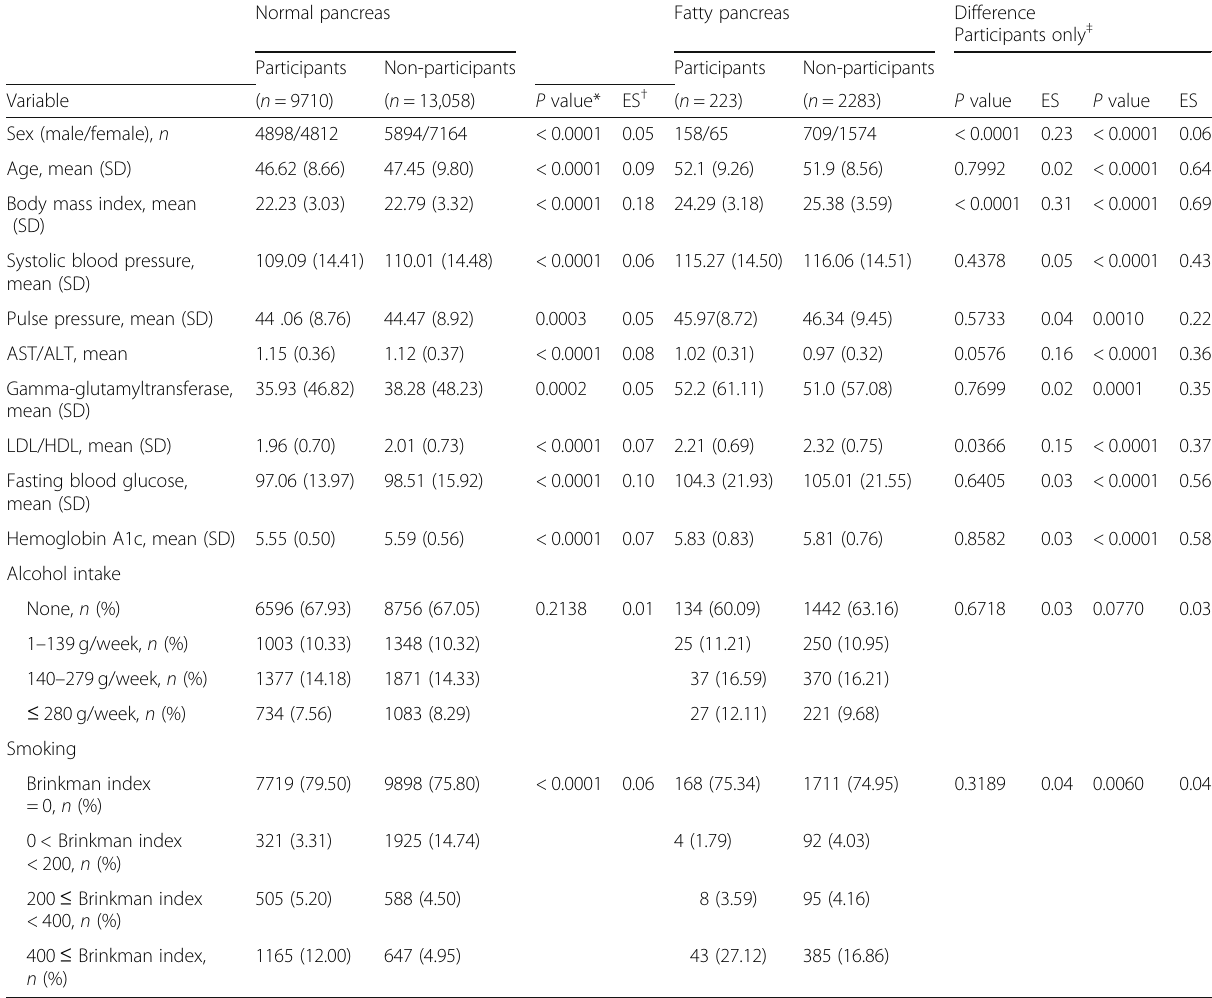
Table 1 Comparison of the baseline characteristics of participants and non-participants in 2014, classified according to the presence or absence of fatty pancreas Normal pancreas Fatty pancreas Difference